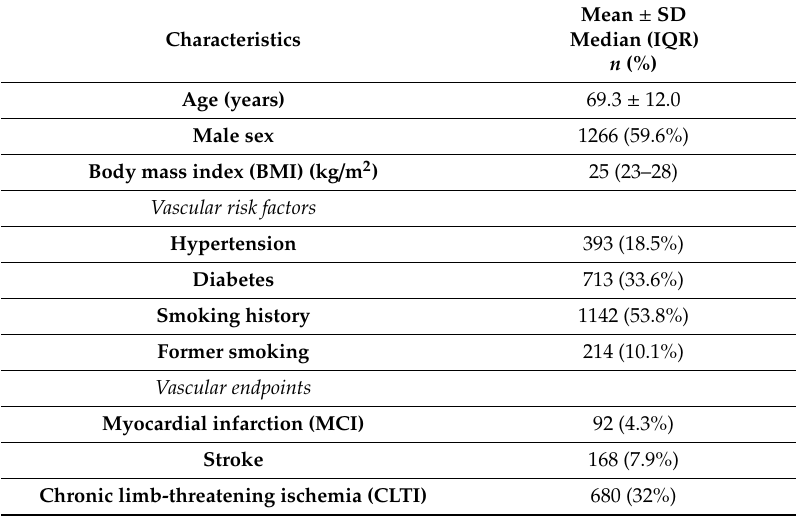
Table 1. Patient